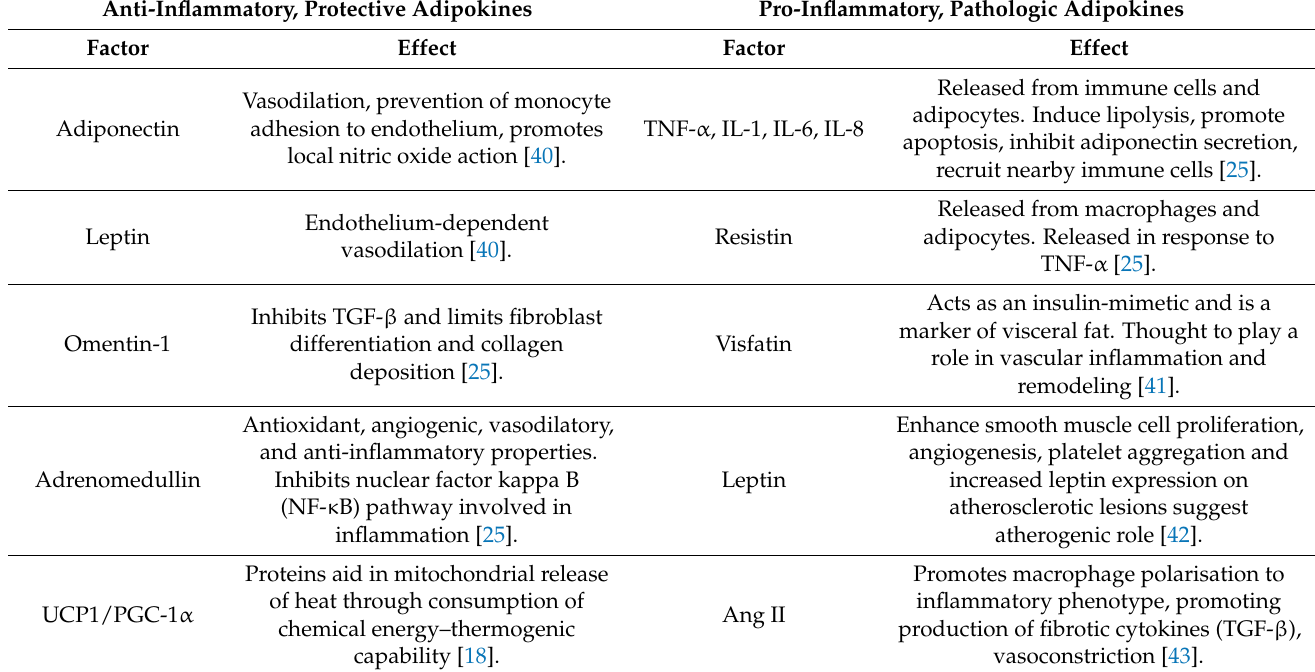
Table 1. Adipokines secreted by EAT and their protective/maladaptive